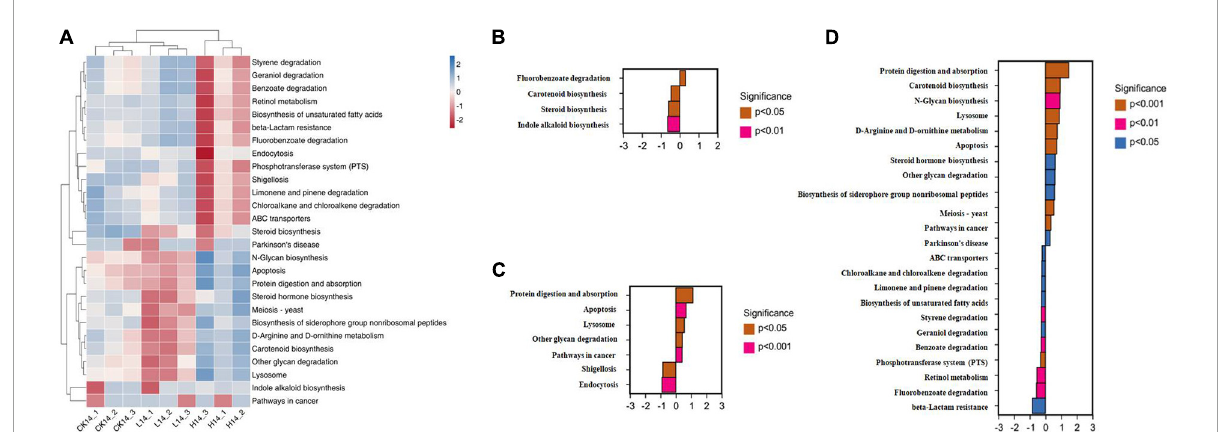
FIGURE5 Intestinal microbiota predictive metabolic functions from the Kyoto Encyclopedia of Genes and Genomes (KEGG) database in all samples. (A) Heatmap of the significant differential pathways among the control (CK14), 0.5 mg/L (L14), and H14 (1.5 mg/L) treatments. (B) Significant different pathways between the control and L14 treatments. (C) Significantly different pathways between the control and H14 treatments. (D) Significantly different pathways between the L14 and H14